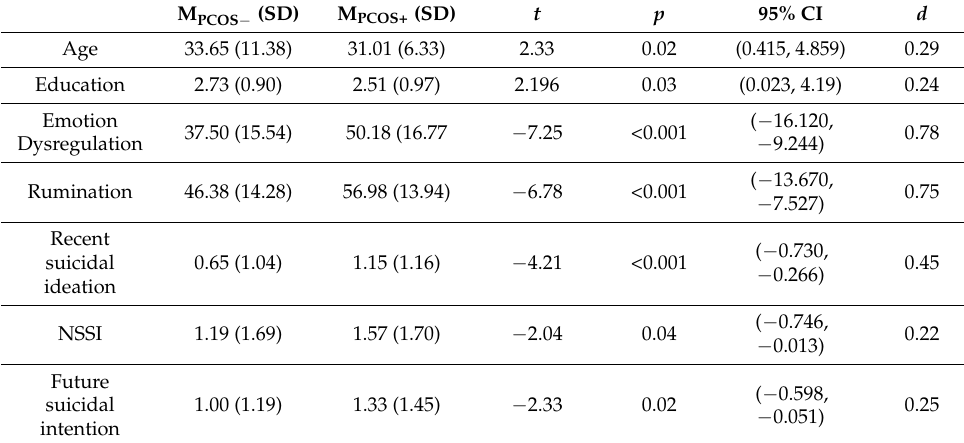
Table 1. Comparisons of variables of interest between women with ( n = 113) and without ( n = 305) a diagnosis of